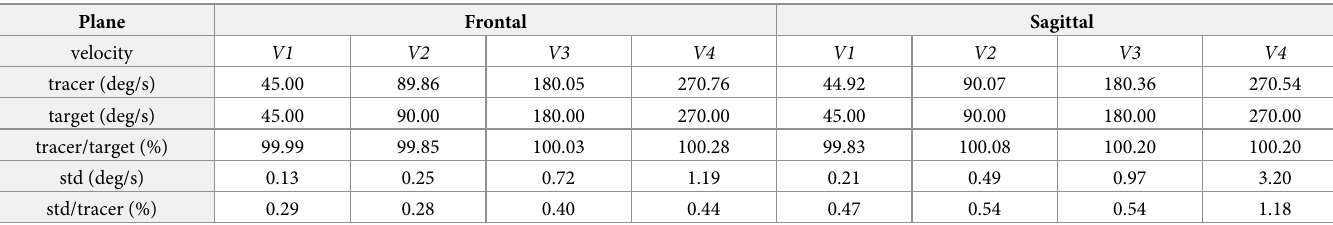
Table 4. Average ω value of target and tracer, and standard deviation of tracer ω value.